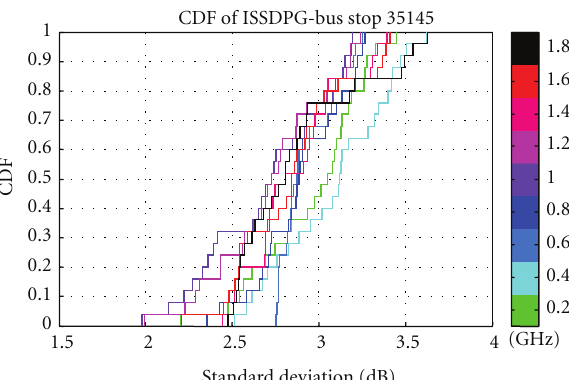
Figure 22: ISSDPG distribution for antenna-shelter (standard sector).